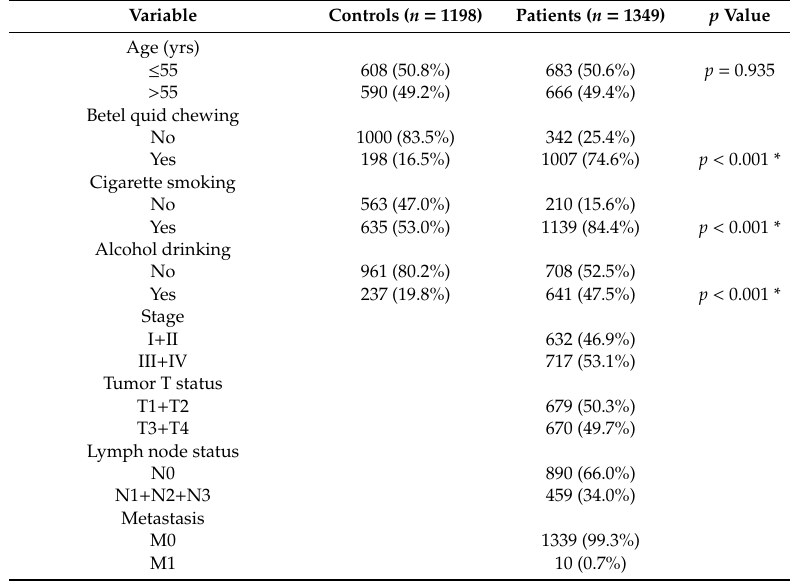
Table 1. Distributions of demographical characteristics in 1198 controls and 1349 male patients with oral